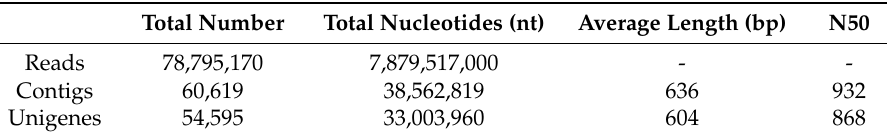
Table 2. Summary for P. citri transciptome.